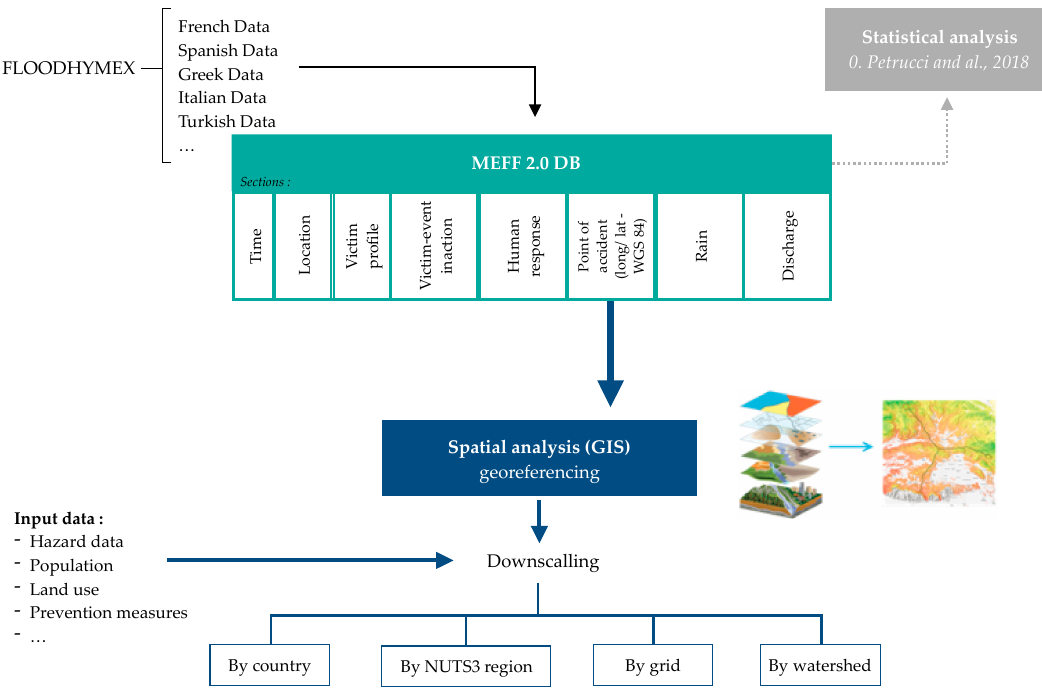
Figure 1. Methods and data for the analysis and valorization of the Mediterranean Flood Fatality Nomenclature of Territorial Units for Statistics Level 3; GIS, geographical information system.